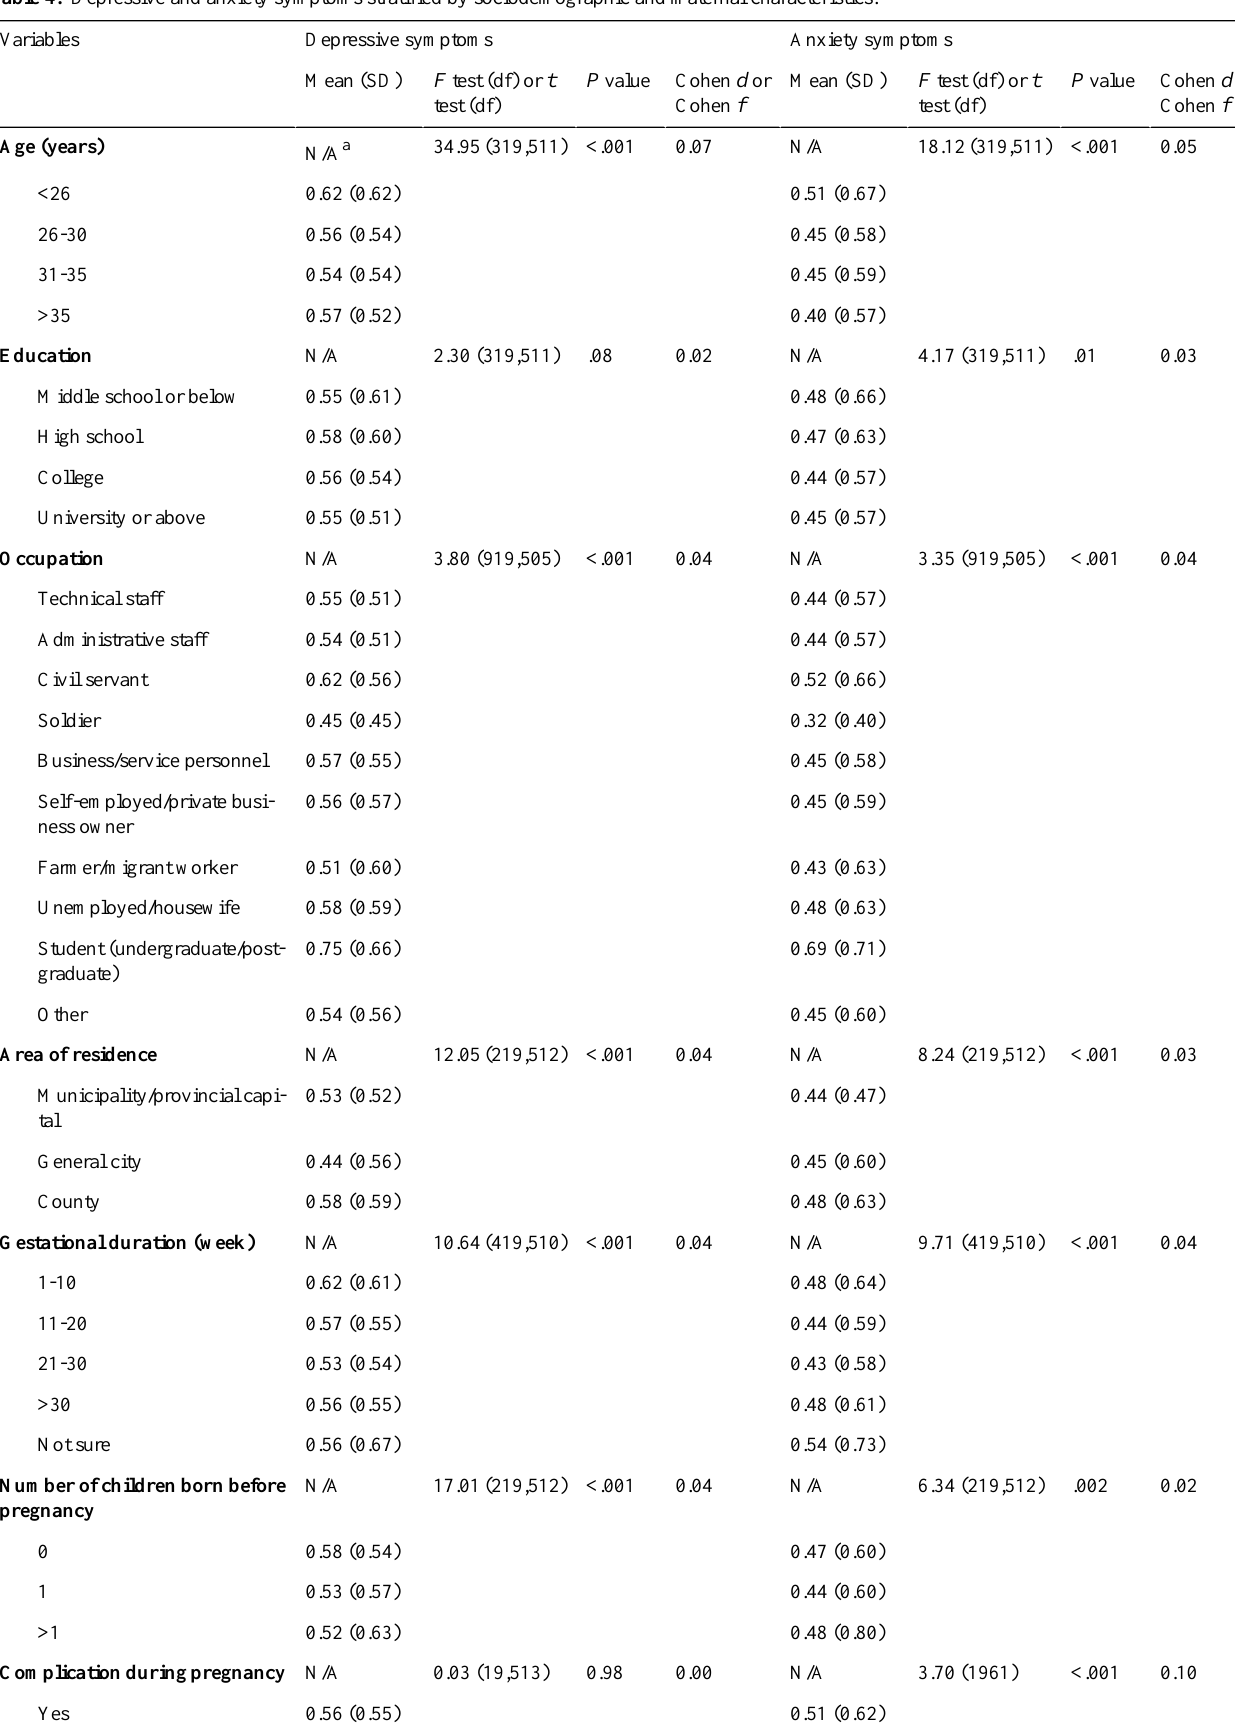
Table 4. Depressive and anxiety symptoms stratified by sociodemographic and maternal characteristics.